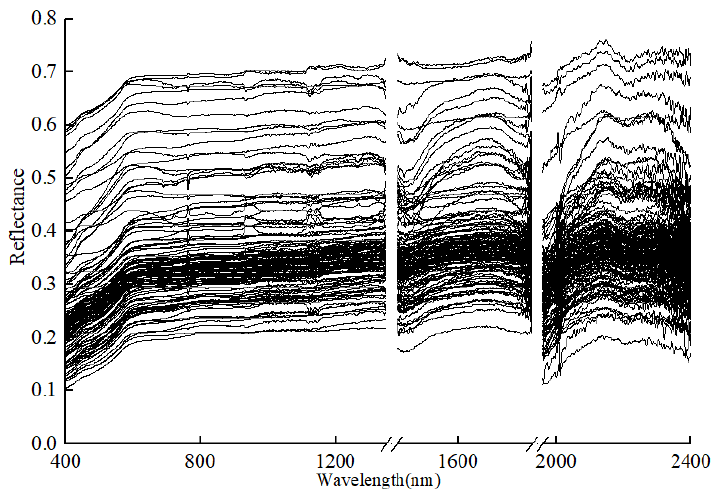
Figure 2. Vis-NIR in situ spectral profile.